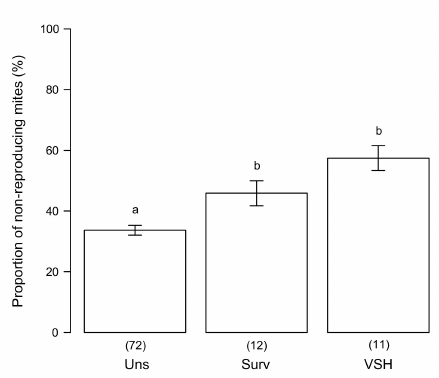
Figure 5. E ff ect of preselection for varroa resistance on the SMR score. Adjusted mean ( ± standard error) SMR scores between an unselected population (Uns, unselected) and two populations selected using varroa-resistance-related criteria (survival: Surv, VSH: VSH). Sample sizes are indicated below each bar and di ff erent letters indicate significant di ff erences between